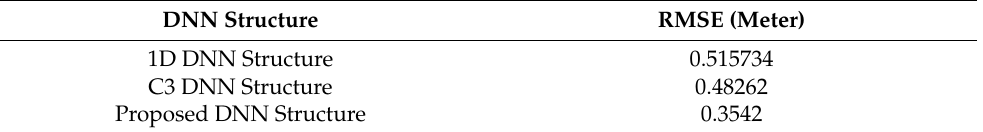
Table 5. Comparison of the proposed DNN structure with the DNN structure of the existing paper.